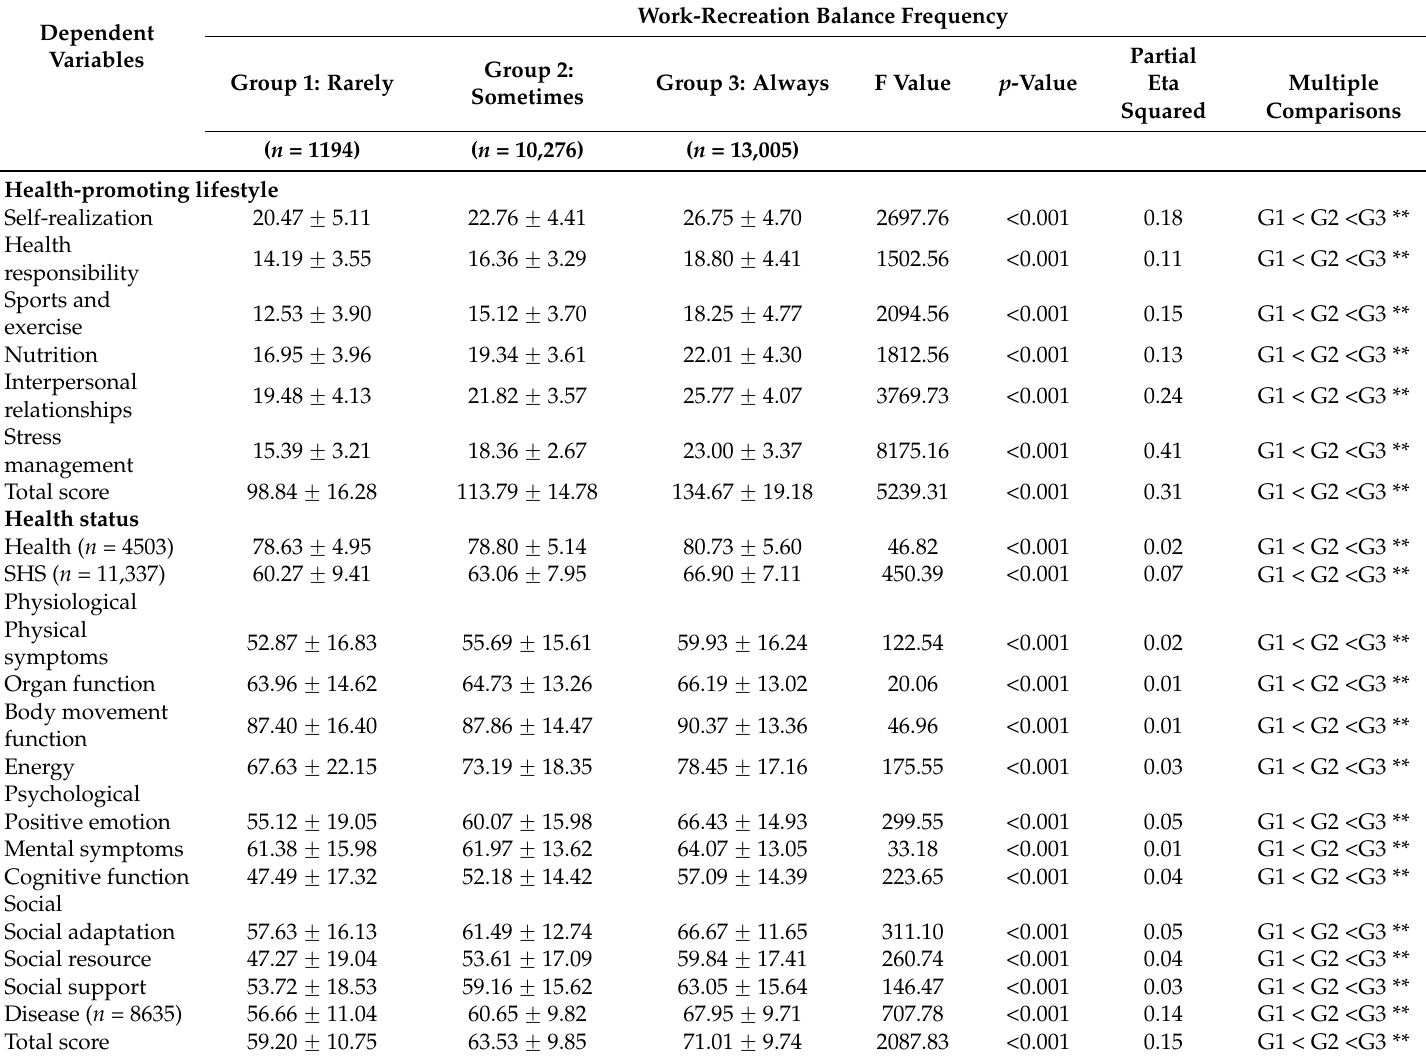
Table 3. The comparison of work-recreation balance frequency in a health-promoting lifestyle and health status (included the factors) using one-way ANOVA.